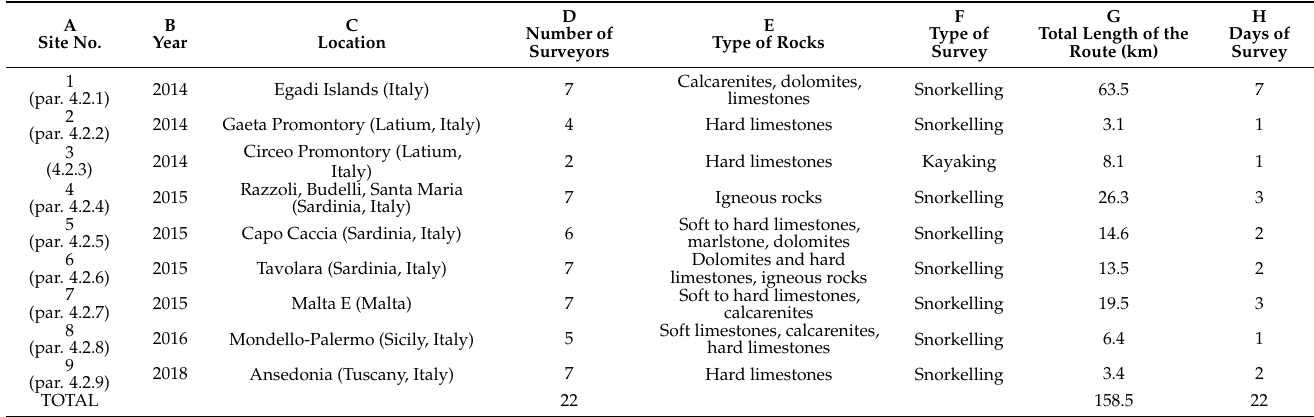
Figure 4. The raft, with cameras and other instruments, used during the snorkel surveys: ( a ) the raft used during the Maltese expedition; ( b ) the raft used at the Ansedonia promontory; ( c ) the raft during an exhibition; ( d ) the raft below the waterline. Table 1. The routes and navigational parameters of the swim survey expeditions from 2014 to 2018 during the Geoswim